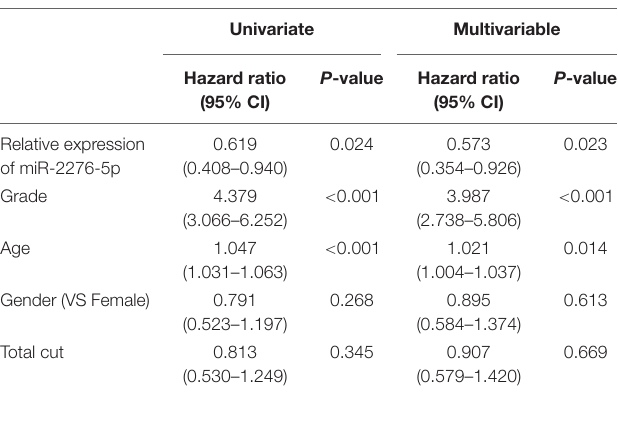
TABLE 3 | The univariate and multivariable Cox proportional hazards regression in glioma